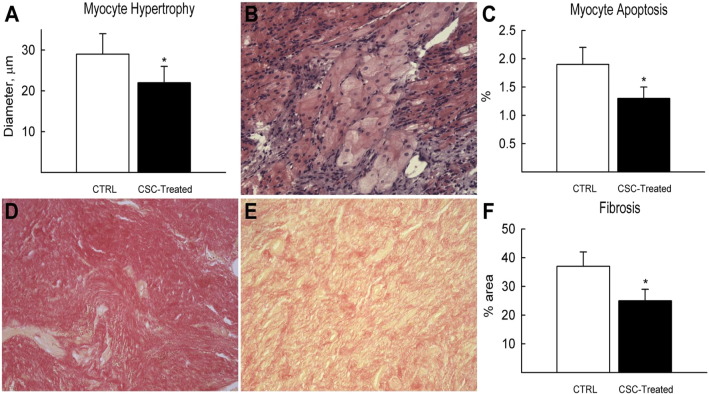
Through paracrine mechanisms, c-kitpos heterologous HLA non-matched CSC treatment preserves myocardial wall structure and attenuates remodeling in a porcine MI model. (A) CSC treatment led to significantly decreased myocyte hypertrophy in the border region. *P < 0.05 vs. CTRL. (B) Representative H&E staining showing a band of hypertrophic myocytes in the border region of CTRL pig myocardium. (C) CSC treatment significantly decreased percent number of apoptotic (caspase 3 positive) myocytes in the border region. *P < 0.05 vs. CTRL. (D & E) Representative images of sirius red staining to identify fibrotic tissue (red) and muscle (yellow) in the infarct region of CTRL (D) and CSC-treated (E) pig hearts. (F) CSC-treated pig hearts had a decreased percentage area fraction of fibrosis in the infarct zone.*P < 0.05 vs. CTRL.